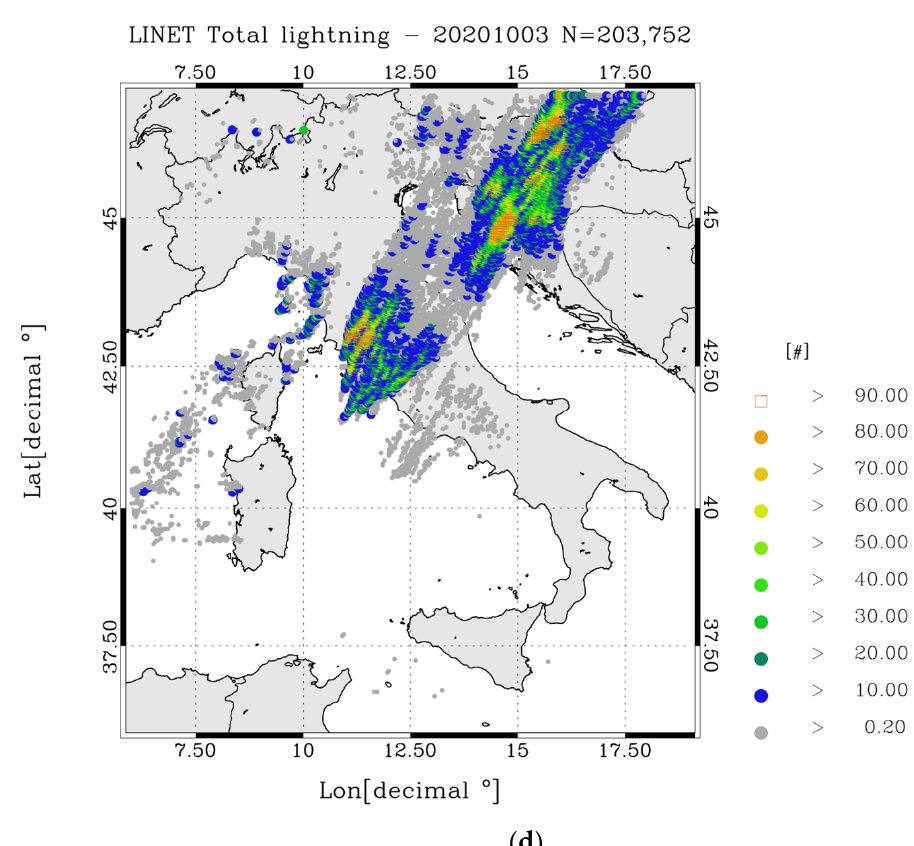
Figure 3. Strokes density field (number of strokes in 9 km 2 ) for 3 October 2020 calculated with a charge transfer setting of ( a ) L50, ( b ) L75, ( c ) L100 for the lightning scheme; ( d ) LINET strokes density. The total number of strokes is shown in the figure title of each panel. The dots represent the daily rate, i.e., the number of strokes accumulated for the whole day in the model grid cells (3 km horizontal resolution). LINET daily data are remapped onto the model grid. Gray dots are smaller than other dots to avoid a large superposition of the dots.